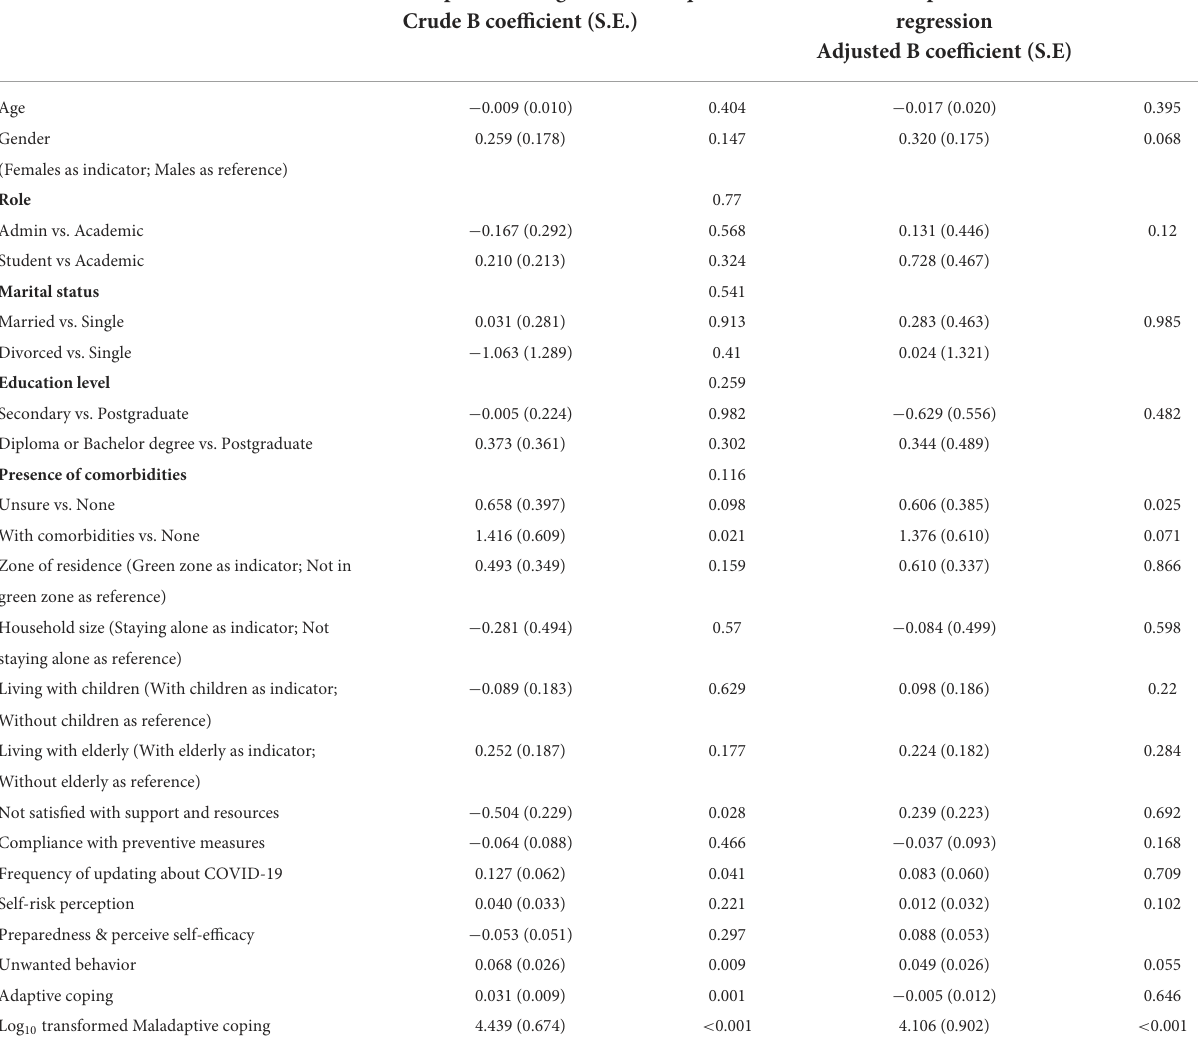
TABLE 6 Factors associated with Coronavirus Anxiety ( n = 434). Simple linear regression p